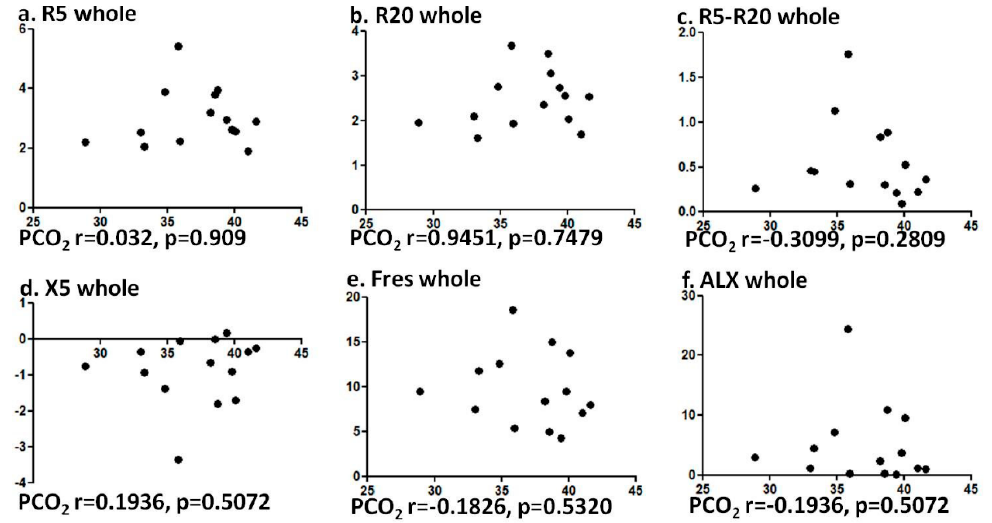
Figure 3. Correlation was not observed between PCO 2 and FOT values among healthy patients. Specifically, correlation between PCO 2 and ( a ) R5, ( b ) R20, ( c ) R5-R20, ( d ) X5, ( e ) Fres, and ( f ) ALX were analyzed using Spearman rank correlation test.